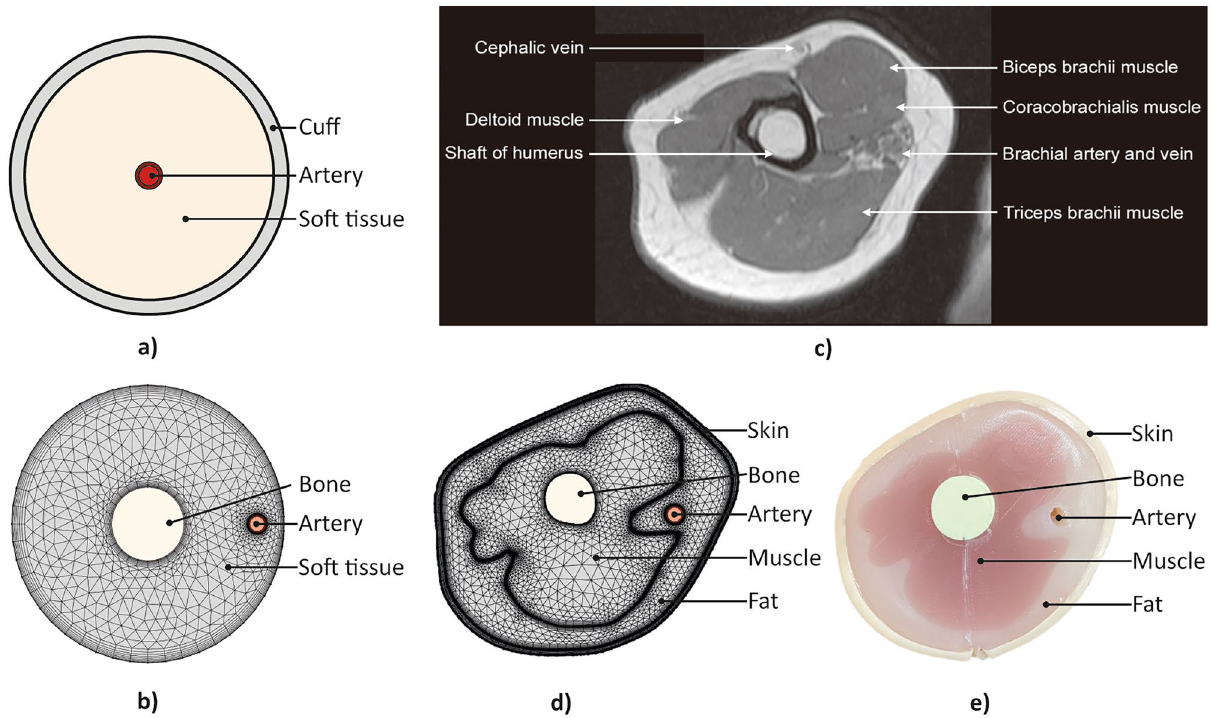
Figure 2. Models and phantom configuration for parametric study and experiment. ( a ) Analytical model based on pressure propagation through concentric components, ( b ) Simple FEM model based on the simplified human arm anatomy, ( c ) Actual MRI image of cross-section of human upper arm, ( d ) MRI-based FEM model from the MRI image in ( c ), ( e ) Cross-sectional view of fabricated phantom based on the MRI image in ( c